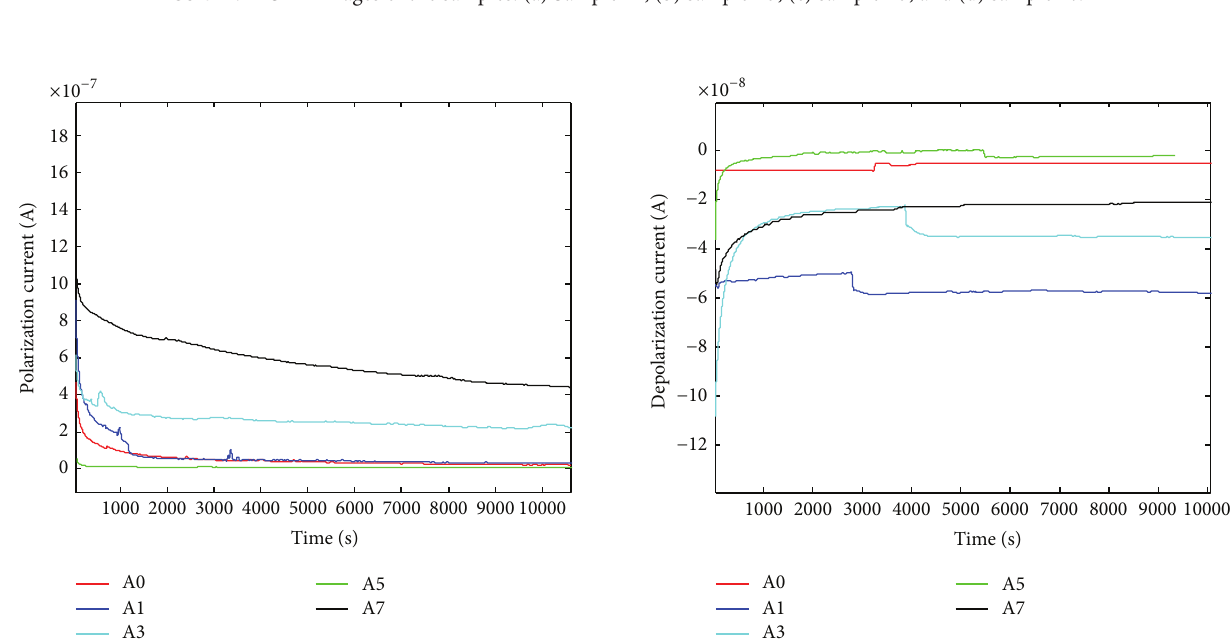
Figure 4: FESEM images of the samples. (a) Sample B1, (b) sample B3, (c) sample B5, and (d) sample B7.